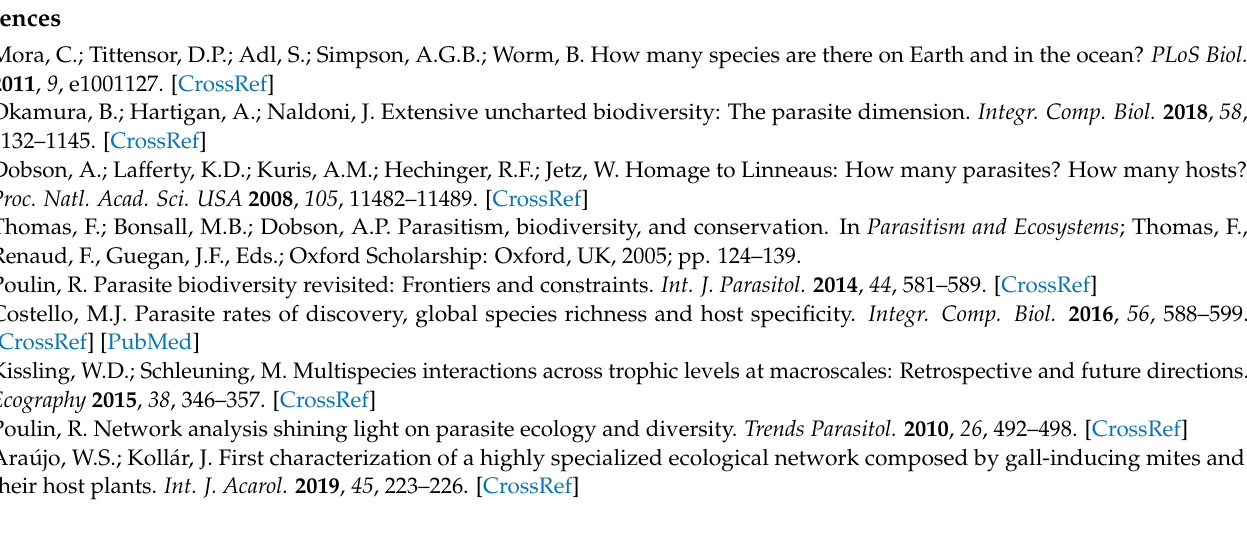
subfamily; Figure S1. A network matrix; Figure S2. Characters; Figure S3. Data